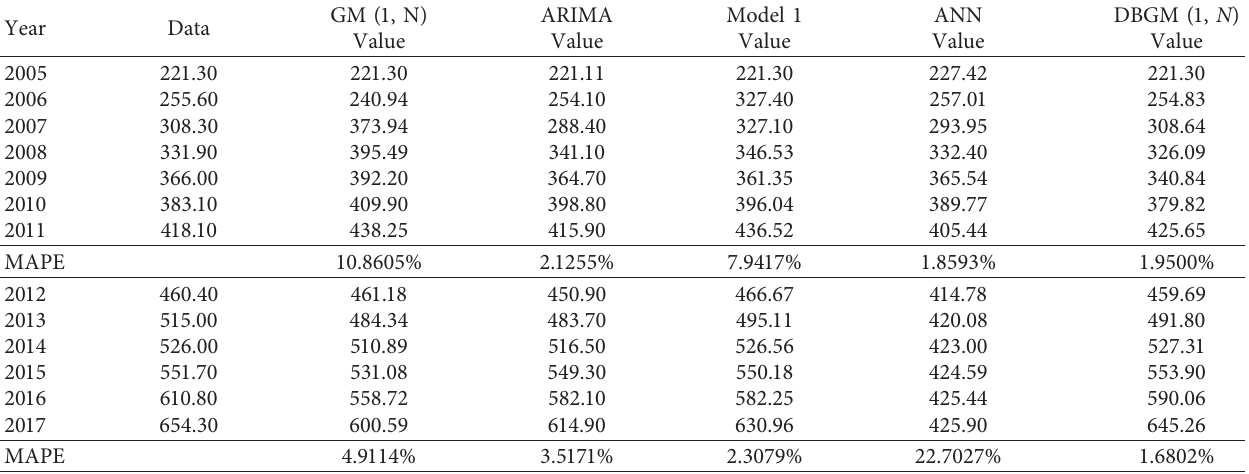
Table 8: The predicted values and APEs of GM (1, N ) model, Model 1, and DBGM (1, N ) model in case 4.